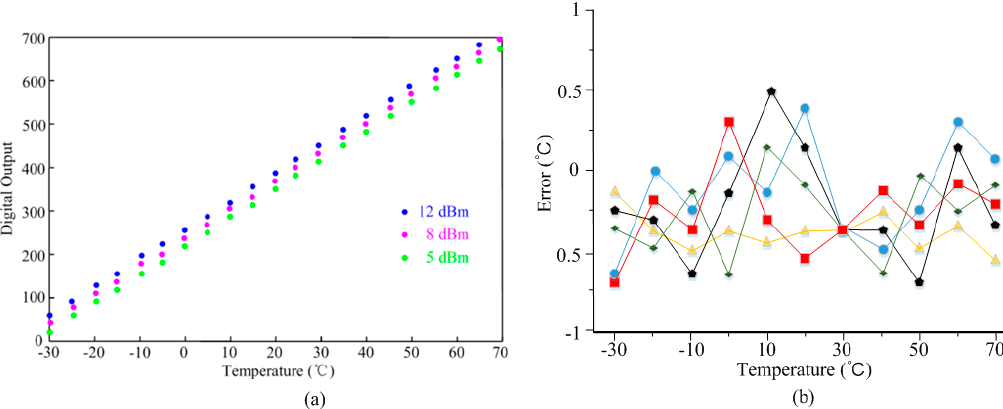
Figure 11. Tested performances of the temperature sensor: ( a ) linearity; and ( b ) error.